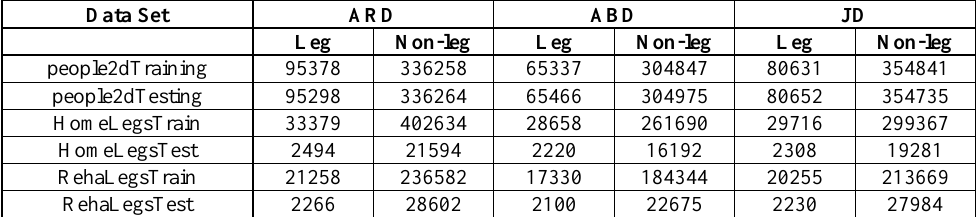
Table 6. Segmentation results of leg segments by different methods for each data set